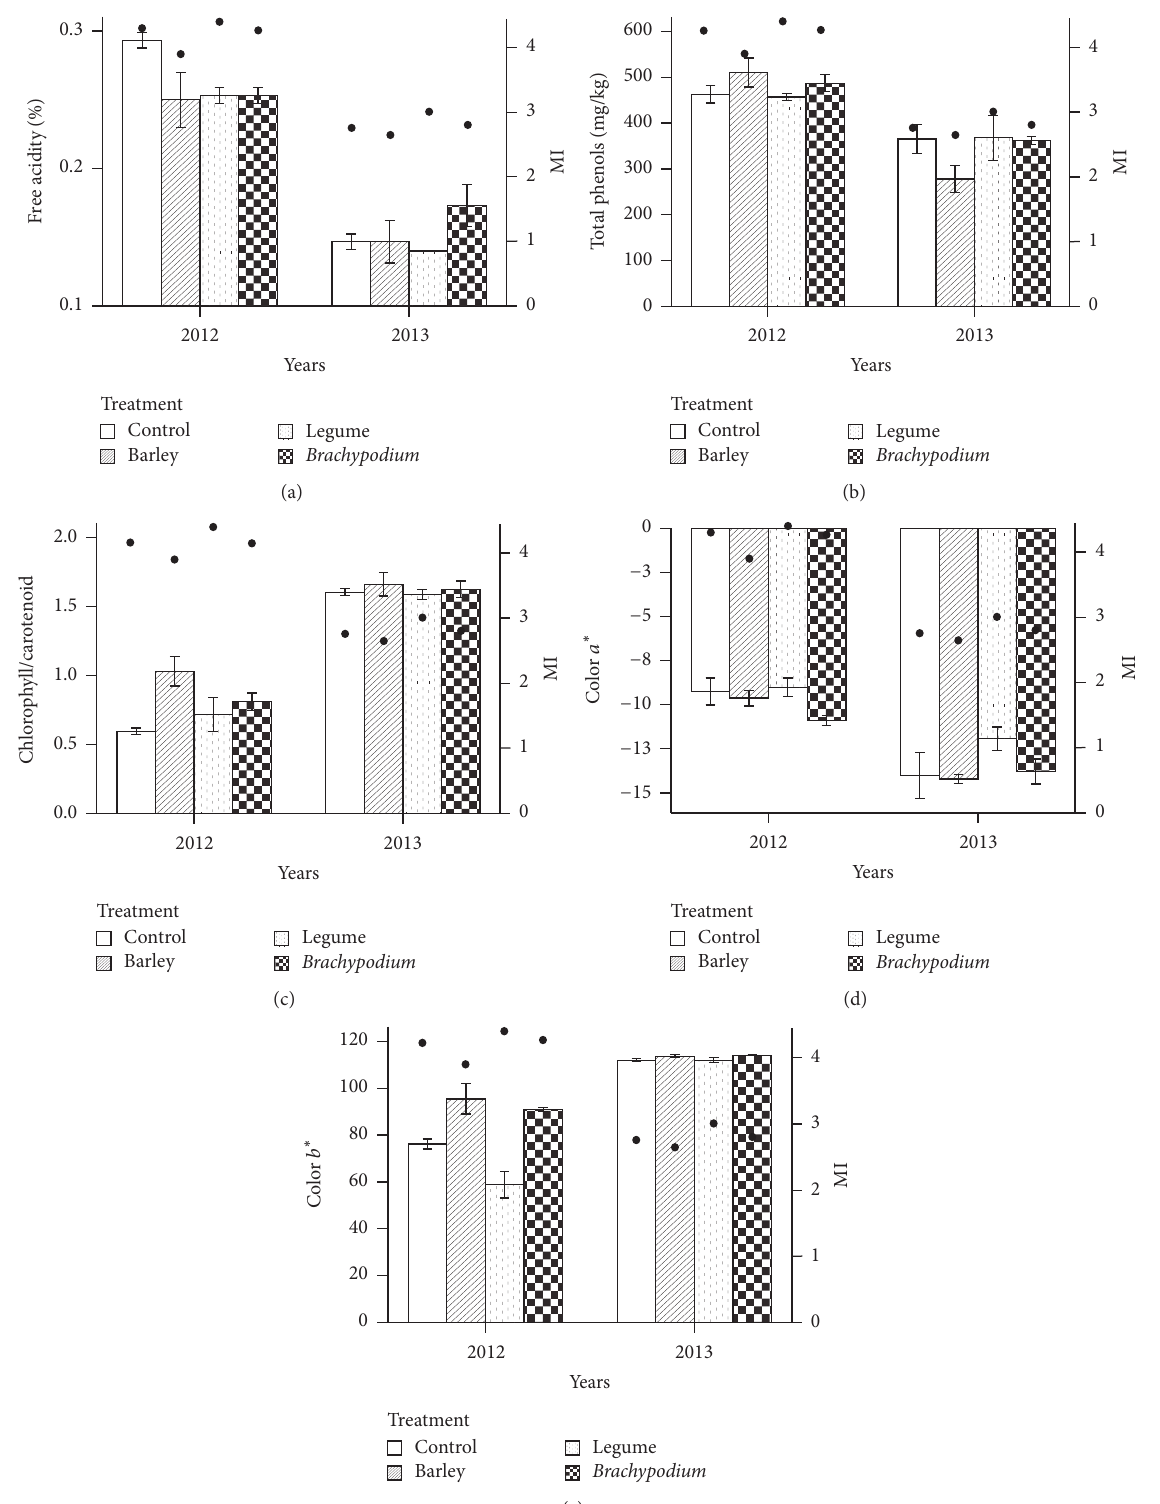
Figure 4: Free acidity (a), total phenols (b), chlorophyll to carotenoid ratio (c), color 𝑎 ∗ (d), and color 𝑏 ∗ (e) mean and standard deviation and maturity index (MI) as dots, of different treatments and